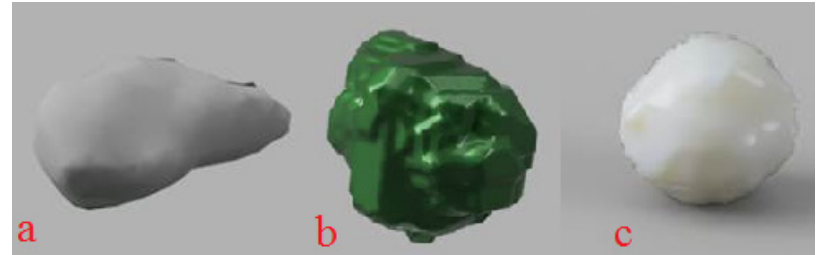
Figure 7. Examples of CT scanned fertilizer particles, ( a ) Agro Organic; ( b ) Agro NPK; ( c ) Substral.